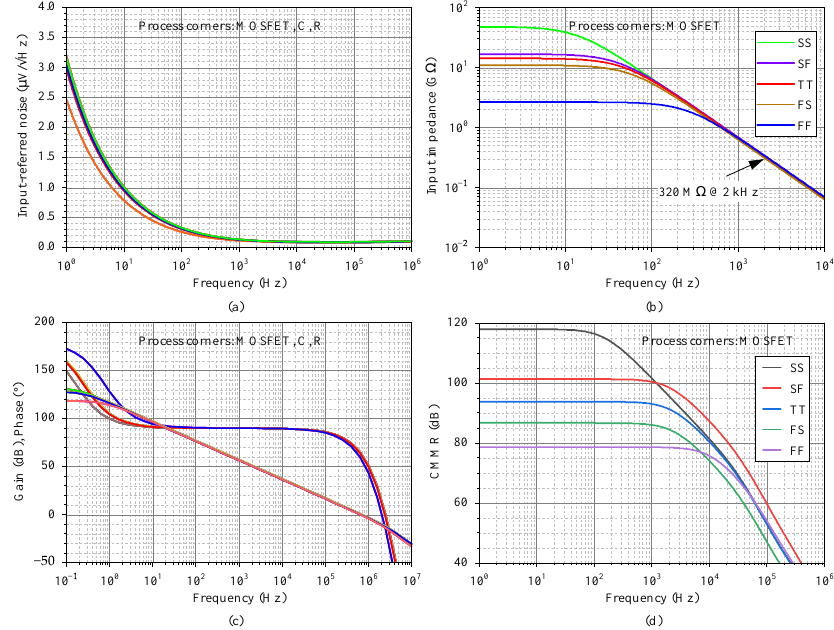
Figure 6. The AC analysis of the circuit from Figure 5, where ( a ) input referred noise, ( b ) input impedance, ( c ) gain including phase, and ( d ) CMRR are shown. The process corners of MOSFETs are listed in the order of NMOS-PMOS, where S is slow, T is typical, and F is the fast